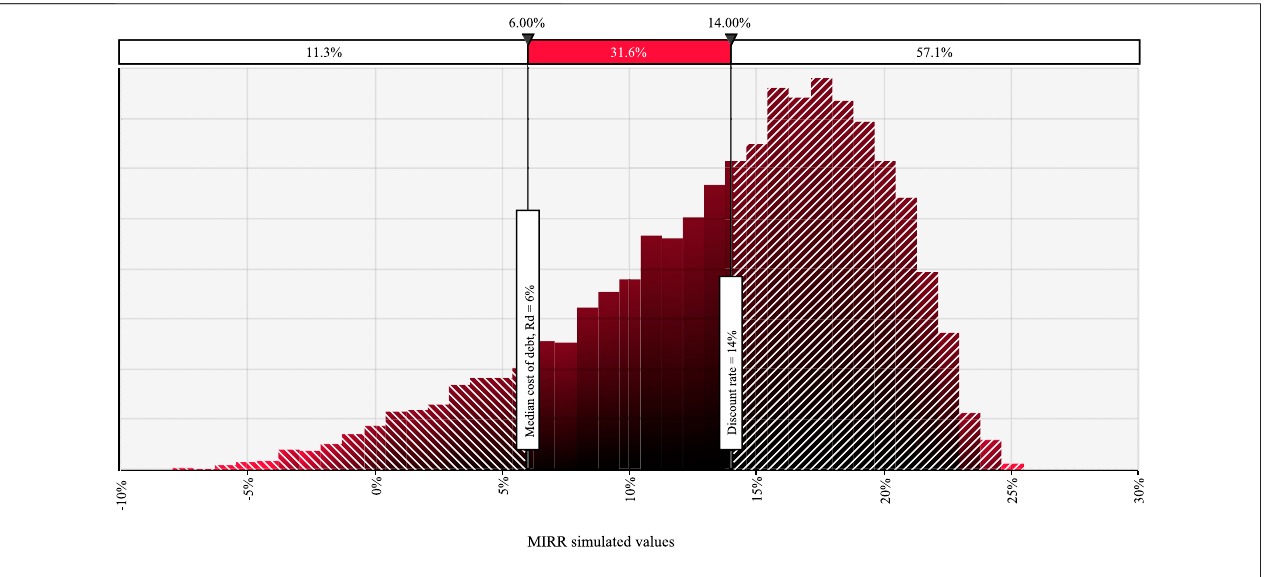
FIGURE3| SimulationsofMIRR(%)forthepennycresscrushingfacility(10,000iterations)usinga14%discountrate,andassumingpennycressfeedstockbought at 10.77 ¢ pound − 1 , which is the average stochastic breakeven price.